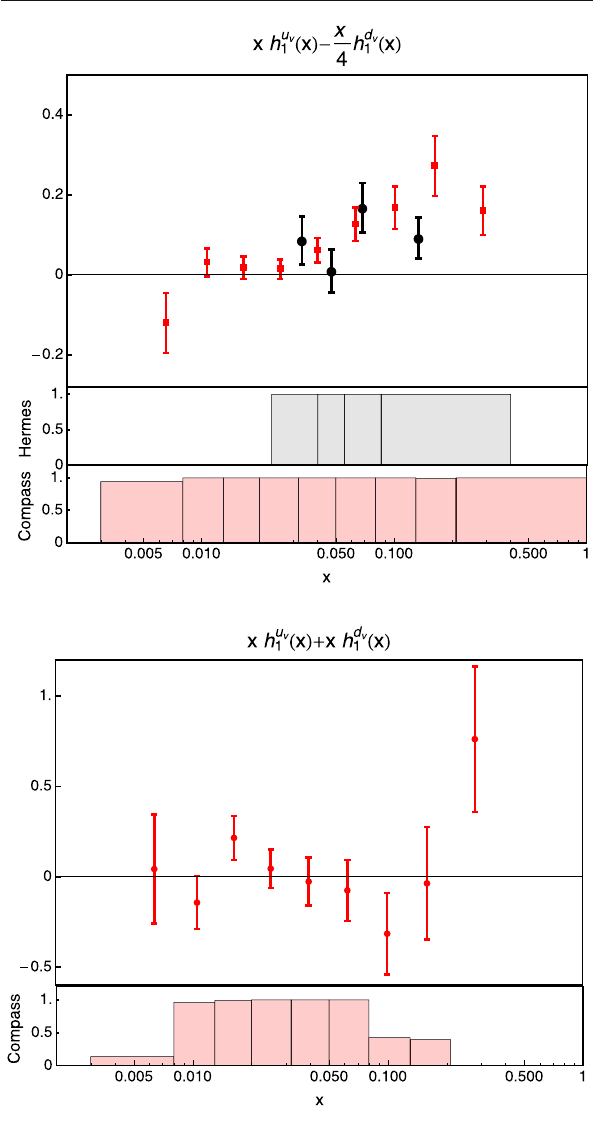
Fig. 2 Combinations of transversities for the proton (upper) and the deuteron (lower) as extracted in Ref. [8]. The bottom plots show the statistical weight for each bin as evaluated through F ( t